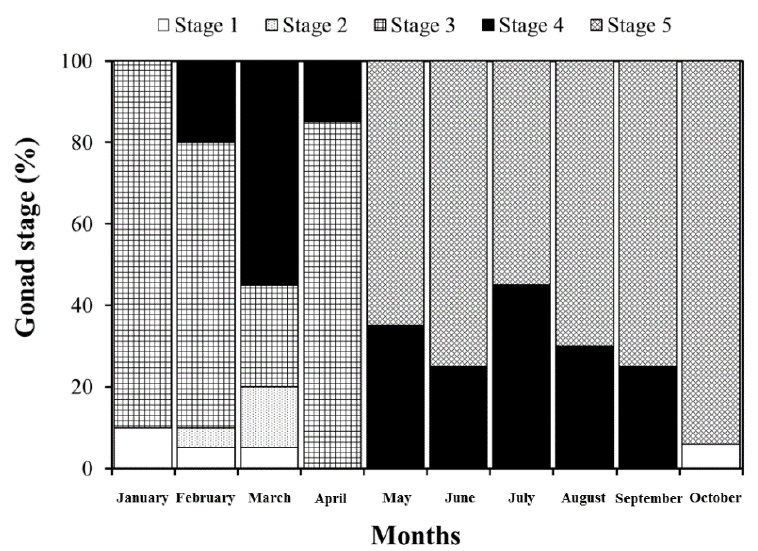
Figure 5. Monthly variation in gonad developmental stages of Ostrea denselamellosa collected from Tongyeong, South Korea, from January 2021 to October 2021.